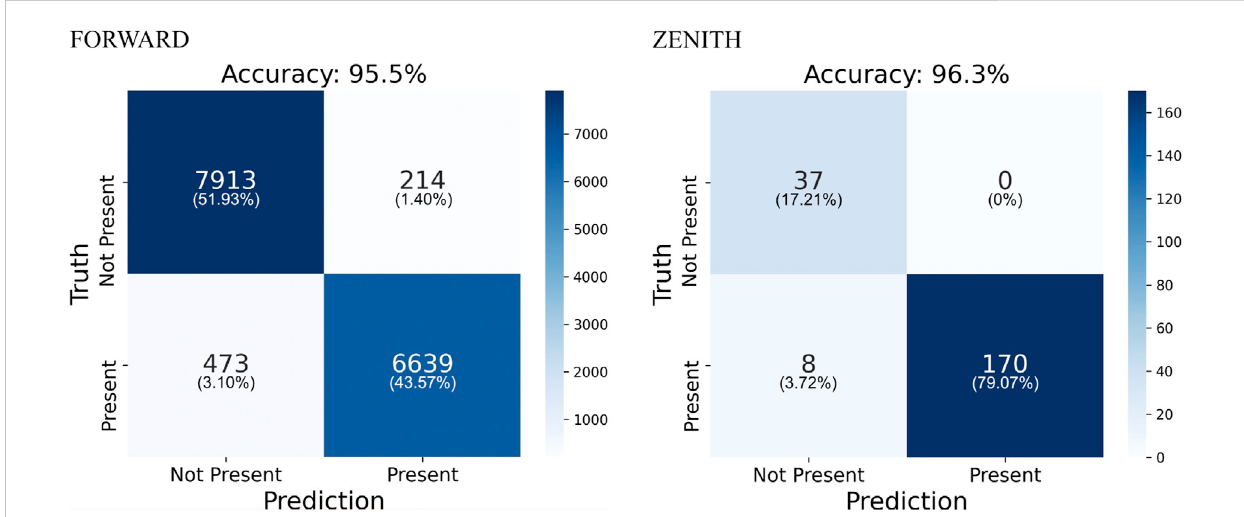
FIGURE 5 CDNN confusion matrices. Binary confusion matrices for the forward CDNN and zenith CDNN models. The forward CDNN is tested against setK , and the zenith CDNN is tested against setV . We use the term Truth as the label for our human-labeled testing dataset and Prediction as the label for the CDNN model ’ s prediction for cloud presence. The grid view demonstrates how CDNN models detect clouds both correctly and incorrectly against human-labeled data. Finally, we de fi ne accuracy as ((Cloud Not Present Match) + (Cloud Present Match)) / (Total Entries in Testing Dataset)